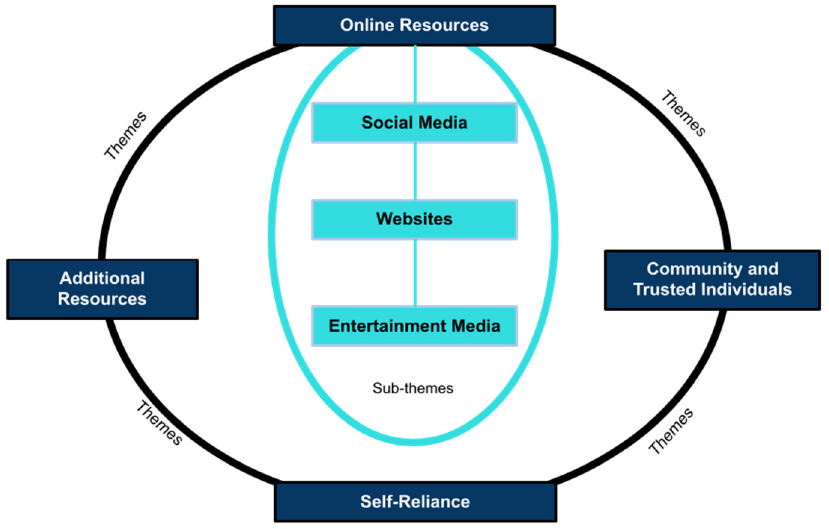
Figure 2. Study Themes and Sub-Themes.